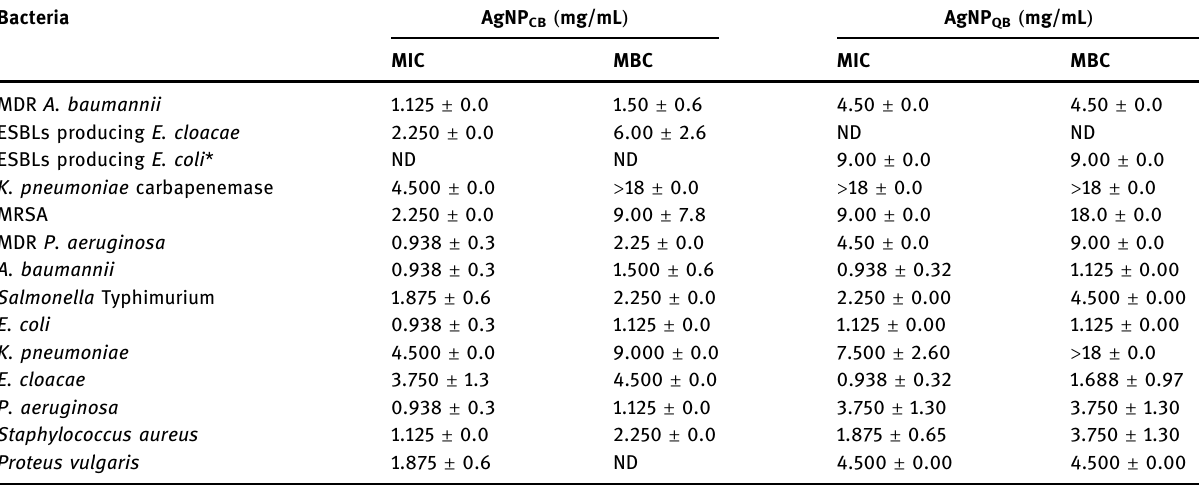
Table 3: MIC and MBC of biologically synthesized AgNP CB and AgNP QB Bacteria